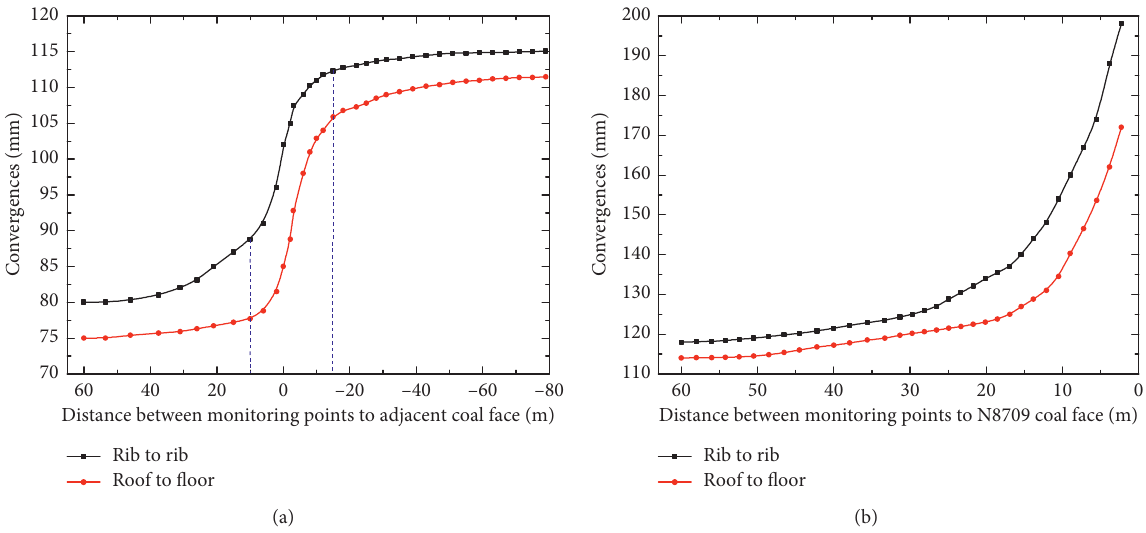
Figure 13: Results of mine pressure observation of Tailgate 8709 in No. 11 coal seam: (a) in the mining process of adjacent coal face; (b) in the mining process of the N8709 coal